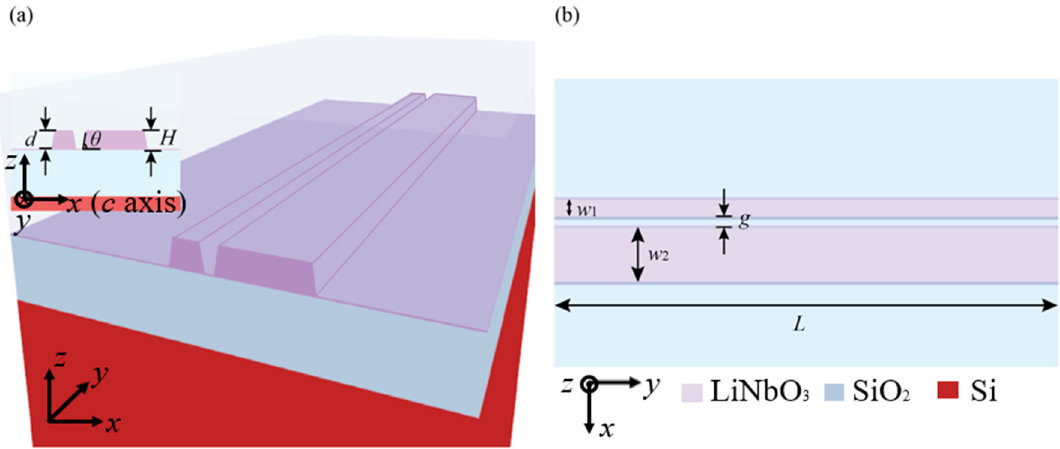
Figure 1. ( a ) The 3D schematic diagram of the dual-coupled waveguide on x -cut LNOI. Inset: the cross-section view of the dual-coupled waveguide. The c -axis is the optic axis of the thin film LN and is parallel to the x -axis. ( b ) The 2D top view of the dual-coupled waveguide.